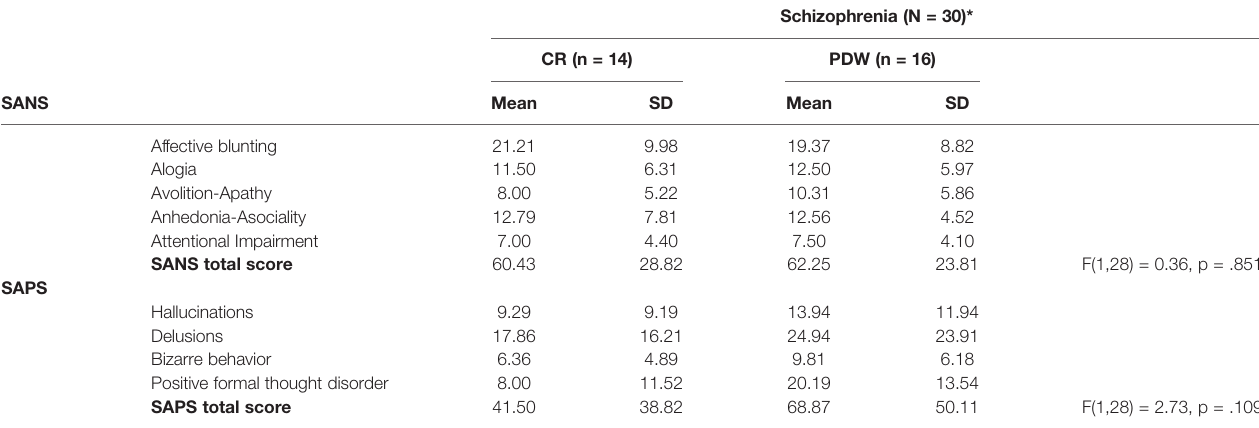
TABLE 2 | Psychopathological characteristics of the CR and PDW groups and group differences in SAPS and SANS scores among patients with